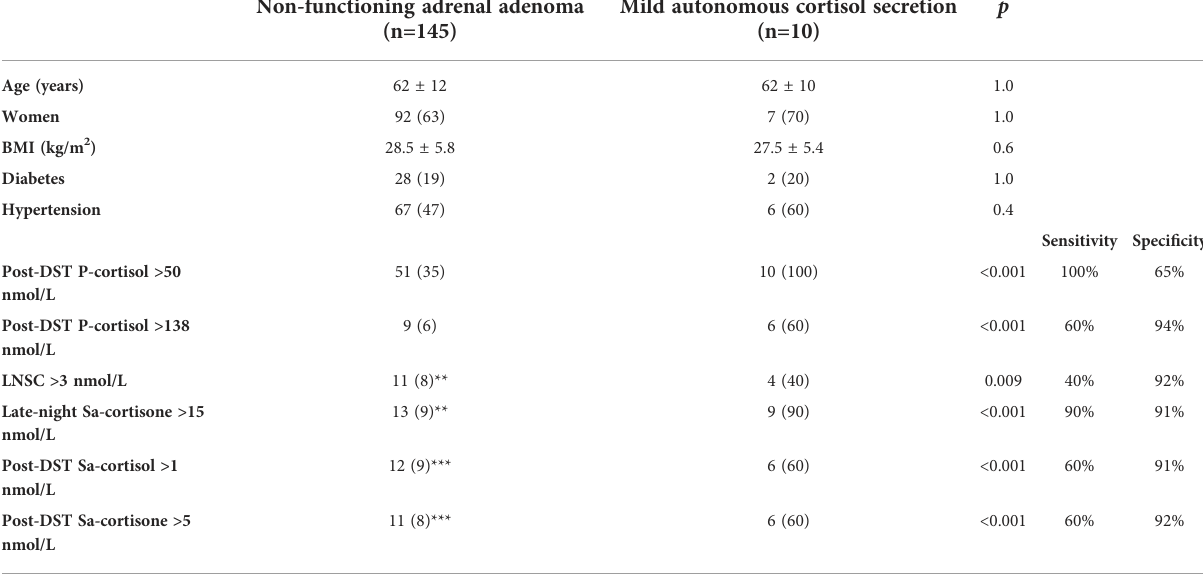
TABLE 1 Characteristics of patients with non-functioning adrenal incidentaloma and autonomous cortisol secretion who provided salivary samples for analysis of cortisol and cortisone during the study period (April 2018 – November 2020). Non-functioning adrenal adenoma